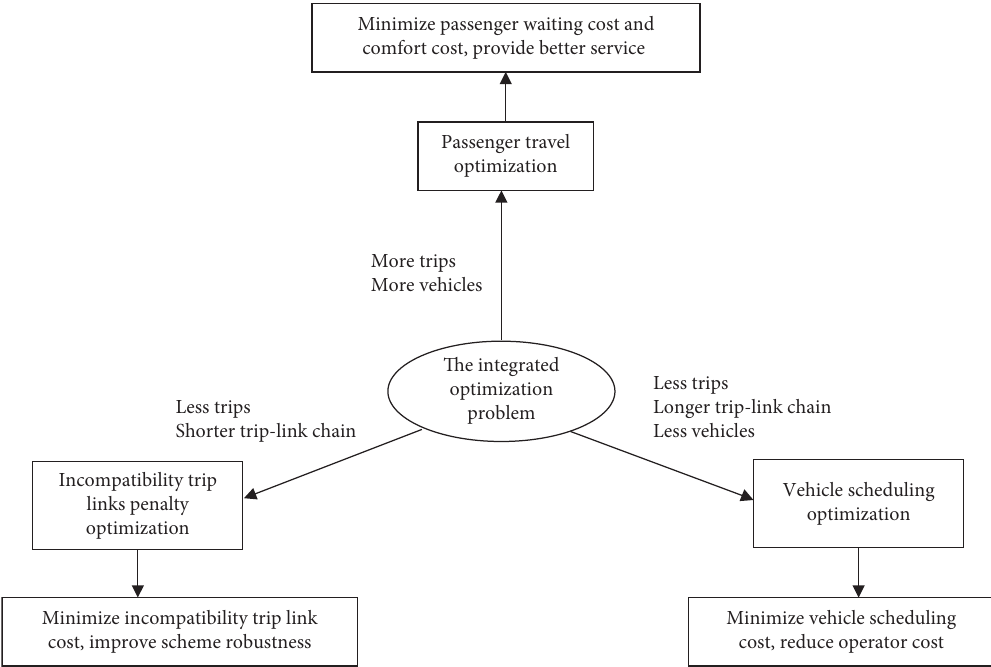
Figure 6: The conflict objectives of the integrated